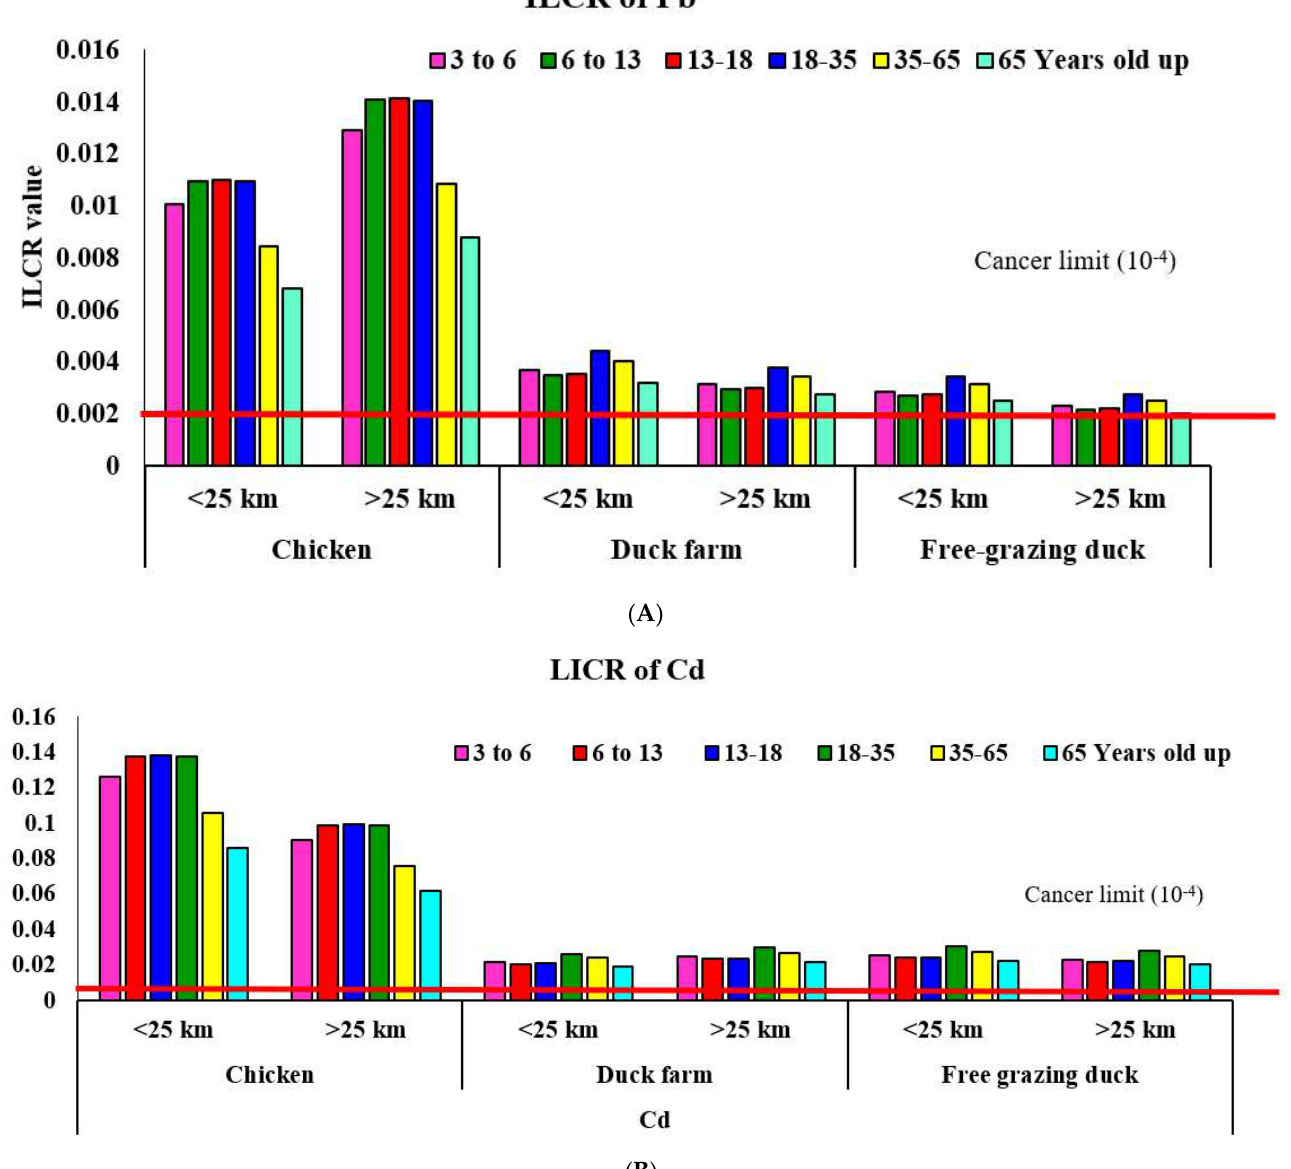
Figure 1. ILCR (incremental lifetime cancer risk) of Pb ( A = upper graph) and Cd ( B = lower graph) from egg consumption in areas located < 25 km and > 25 km from the gold-mine site (the red line indicates a cancer limit of 10 −4 set by the USEPA).